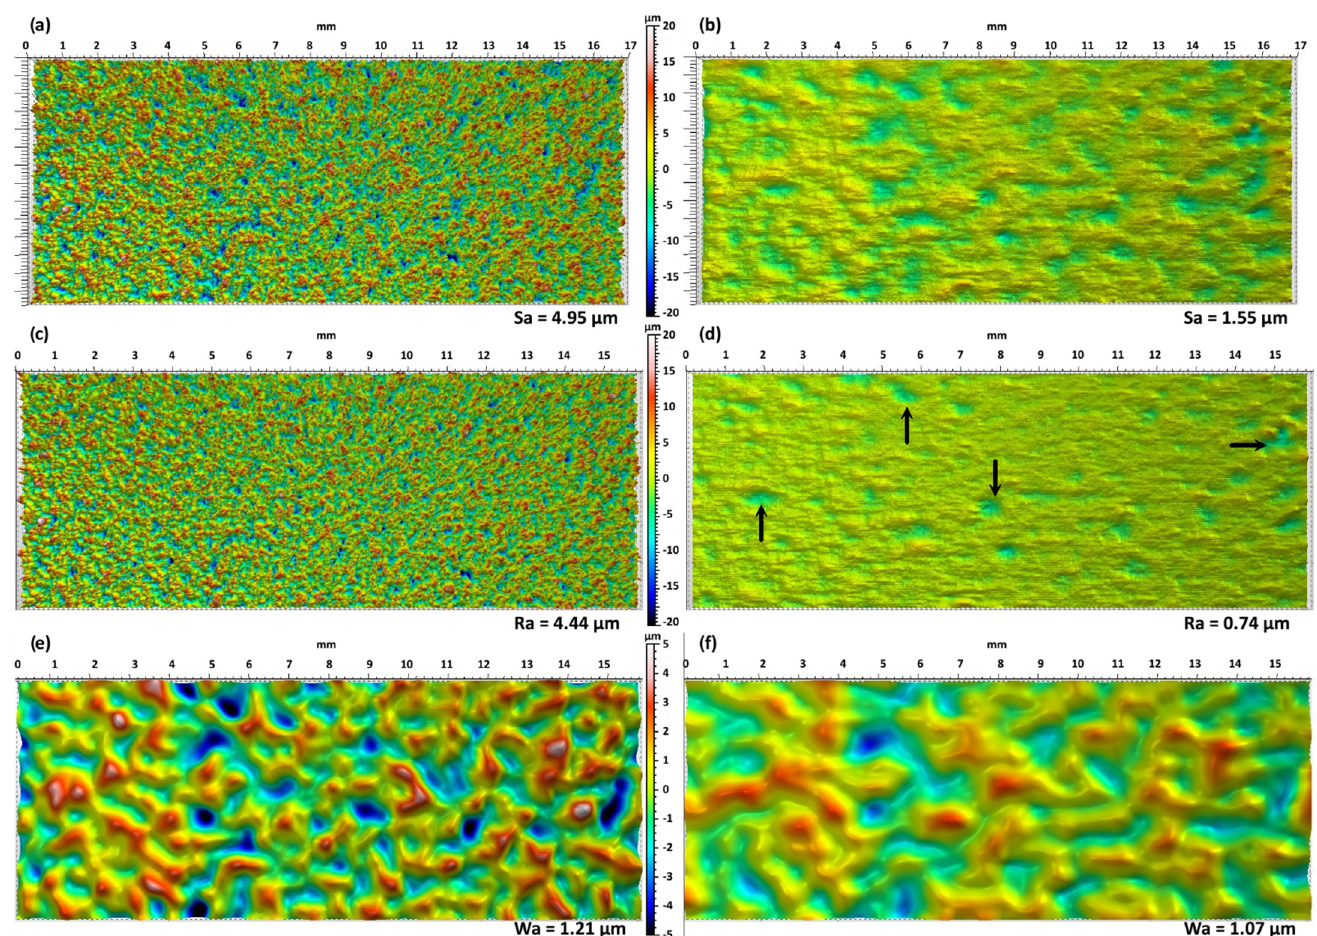
Figure 7. Topography measurement for the test DoE4 before (left-hand side) and after (right-hand side) LP. ( a , b ) show the unfiltered filtered ( Sa ), ( c , d ) show only the roughness of the surface with a cut-off of 0.8 mm ( Ra ) ( e , f ) show only the waviness of the surface with a cut-off of 0.8 mm ( Ra ). For each line, the vertical color scale is the same in order to compare the surfaces and is indicated in the middle. The scale for the waviness is lower as the original waviness is much lower than the original roughness (1.21 μ m vs. 4.44 μ m).